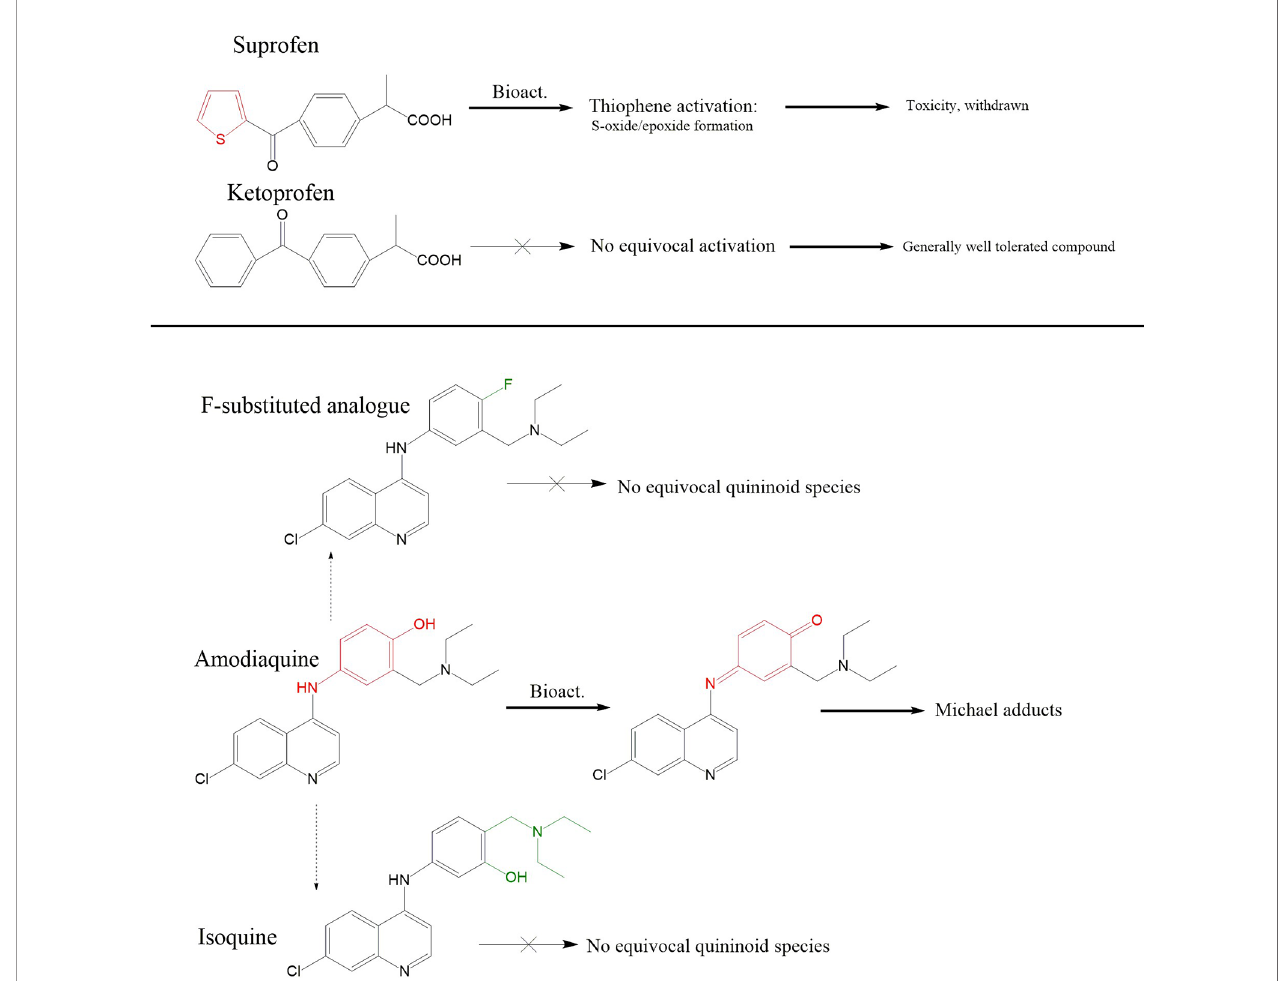
FIGURE 7 | Pharmaceutical application of structural alert chemistry. Top panel; Disparity in metabolic fates of suprofen and related ketoprofen, and their downstream tolerability pro fi les, are generally attributed to suprofen ’ s possession of the thiophene ring structural alert which is capable of undergoing oxidation to S-oxides/epoxides. Ketoprofen ’ s phenyl ring does not undergo equivalent bio-activation. Middle panel: Iterative synthesis series of amodiaquine in pursuit of a compound with reduced ADR liabilities; Amodiaquine possesses the p-aminophenol structural alert which can be bioactivated to the Michael acceptor ACQI which is reported to be responsible for its idiosyncratic ADR liabilities in a fashion akin to paracetamol and NAPQI. Structural analogues in the form of fl uorination at the 4 positions, or isomerization of the hydroxyl and diethylamino side chain leads to compounds impervious to quininoid